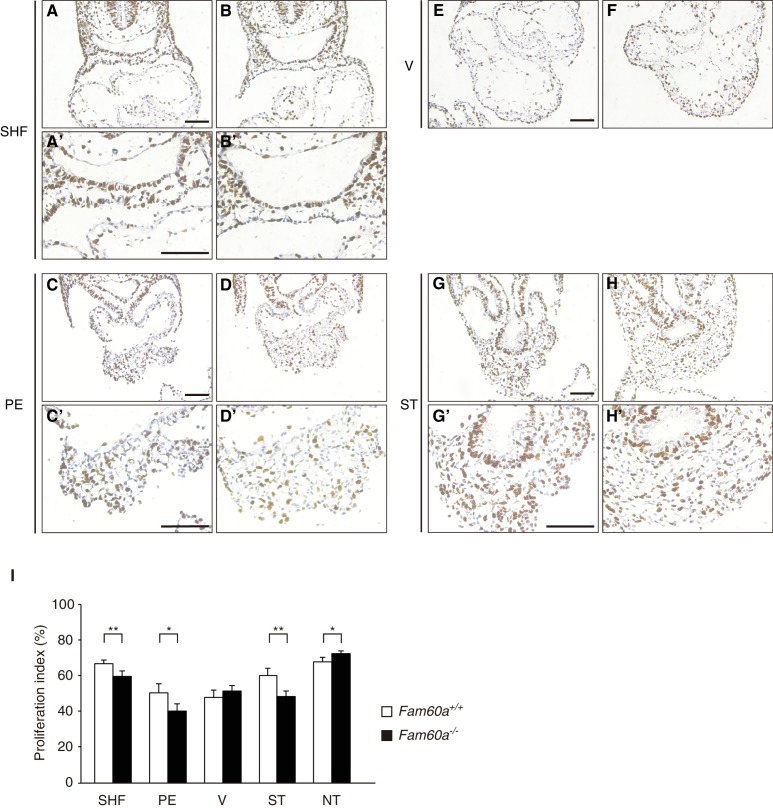
BrdU immunohistochemistry for determination of the proliferation index in Fam60a–/– and WT embryos.(A–H) The secondary heart field (SHF) (A and B), proepicardium (PE) (C and D), ventricle (V) (E and F), and septum transversum (ST) (G and H) of WT (A, C, E, G) and Fam60a–/– (B, D, F, H) embryos labeled with BrdU in utero at E9.0 to E9.5 were sectioned and stained with antibodies to BrdU. Images in (A) through (D), (G), and (H) are shown at higher magnification in (A') through (D'), (G'), and (H'), respectively. Scale bars, 100 µm. (I) Proliferation index determined by BrdU labeling for the indicated tissues of WT (open bars) or Fam60a–/– (closed bars) embryos at E9.0 to E9.5 as in (A) through (H). NT, neural tube. Data are means ± s.d. for five embryos. *p<0.05, **p<0.01 (Student’s unpaired t test).